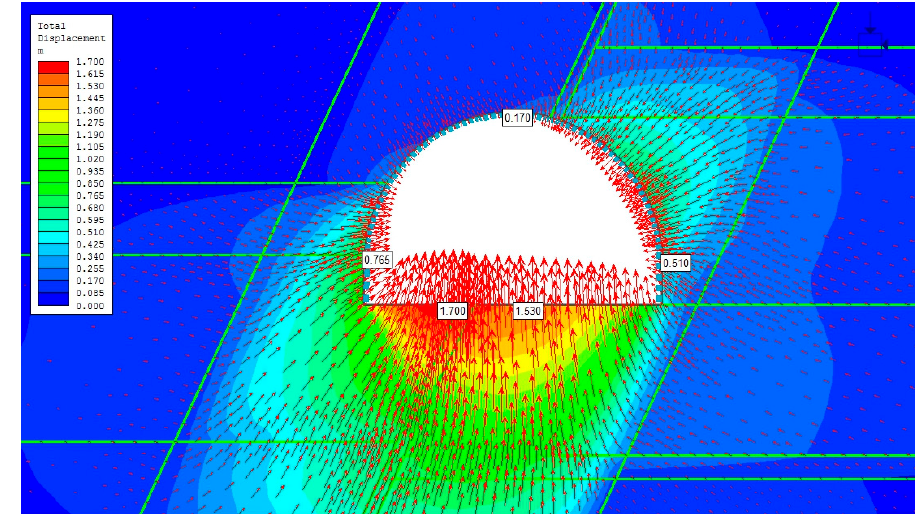
Figure 16. Model no 4—Maingate D-2 in the fault zone—map of total displacement. Figure 16. Model no. 4—Maingate D-2 in the fault zone—map of total